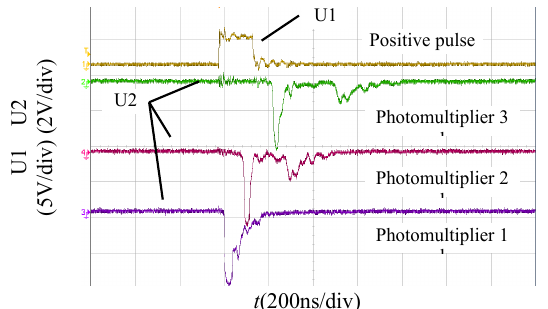
Figure 4. Typical signals from the photomultiplier monitoring the streamer propagation along the surface of the polymer.